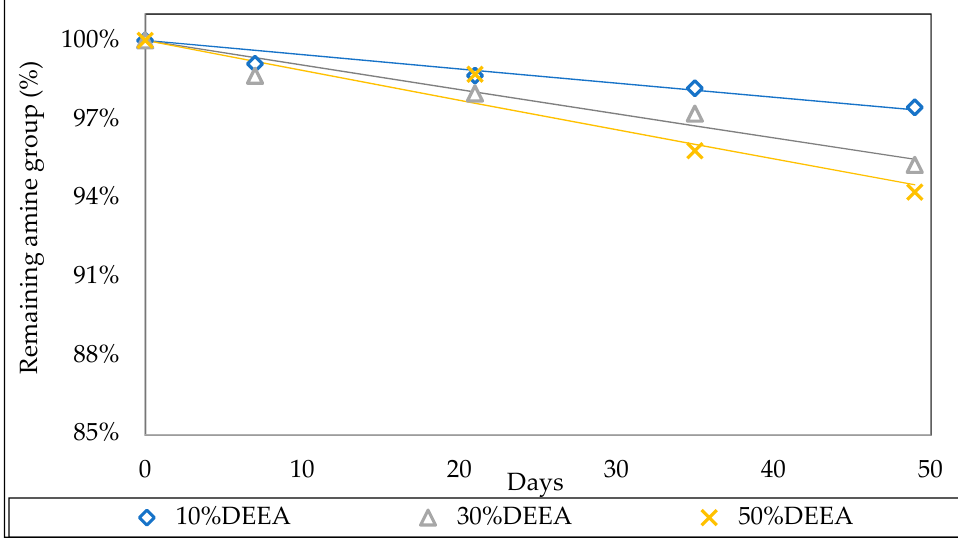
Figure 11. Remaining amine group (%) in various aqueous 2-(diethylamino) ethanol (DEEA) solutions, with solid lines representing the model results at CO 2 loading ≈ 0.4.